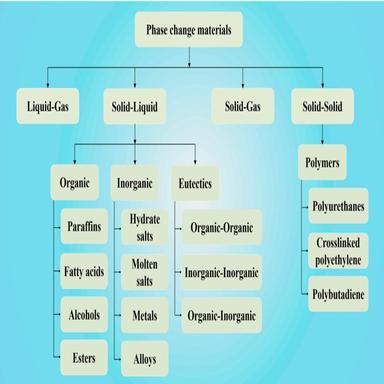
Classification of phase change materials.